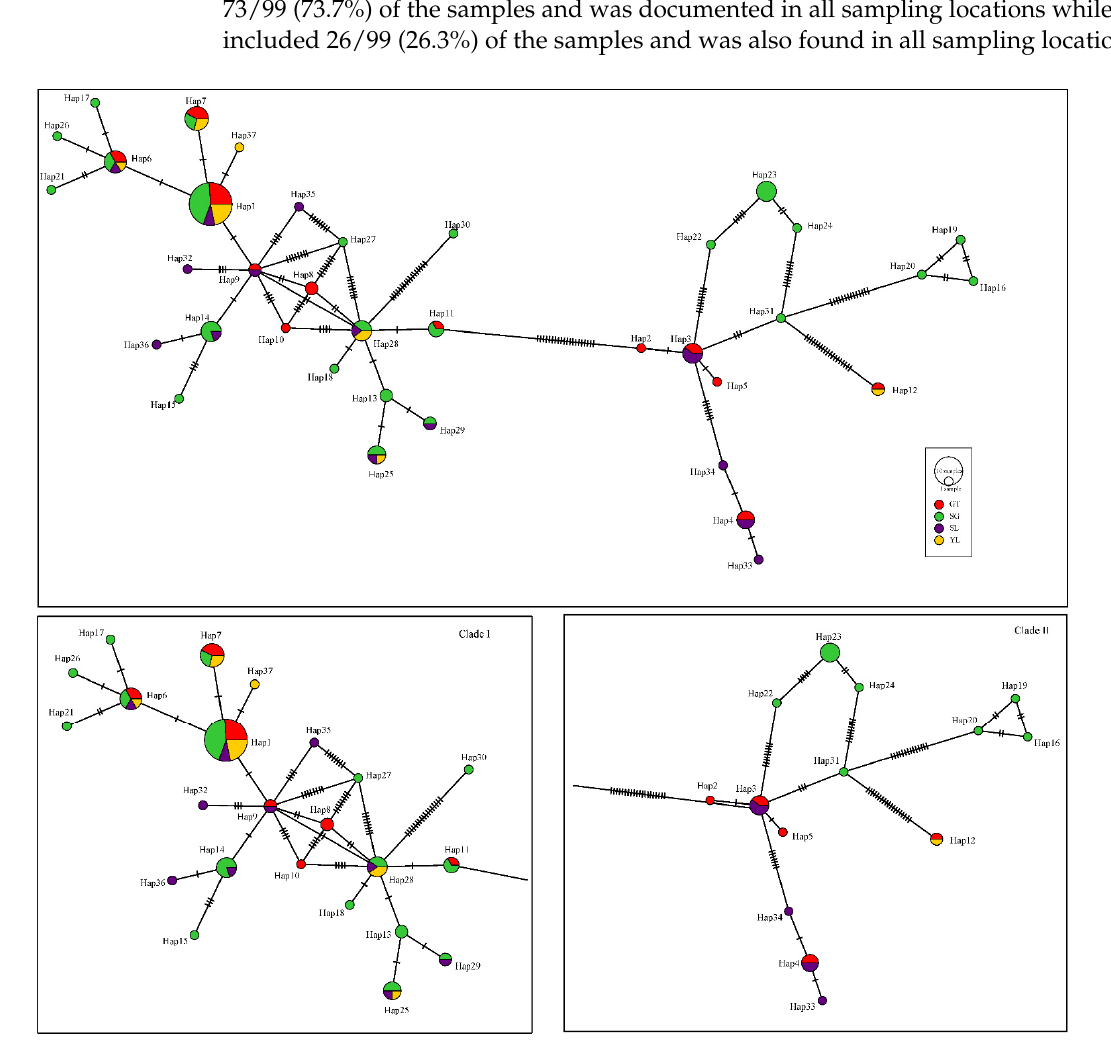
Figure 3. The haplotype network of Schizothorax kozlovi based on the concatenated sequences of gene Cyt b and COI.